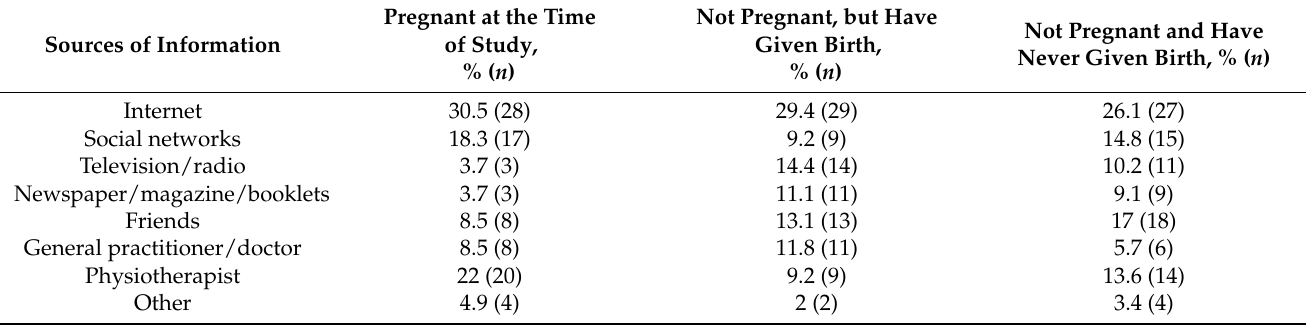
Table 2. Distribution of the answers to the question "Where did you find out about exercise for pregnancy?" depending on respondents’ status.